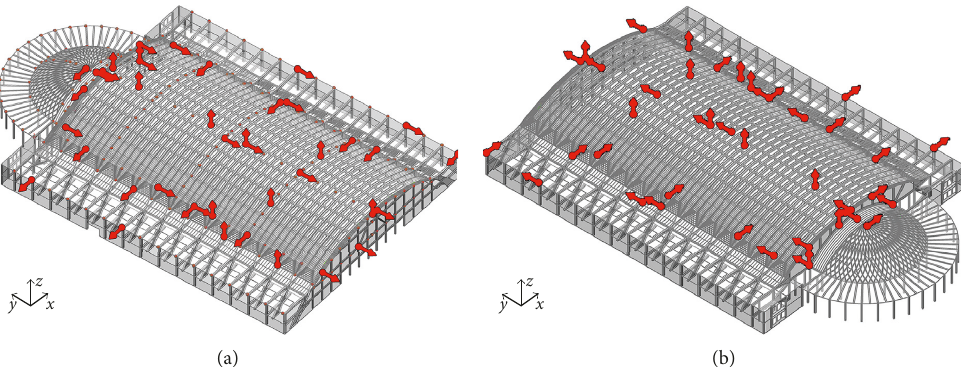
Figure 20: Sensor configuration layout: placement of sensors for the damaged structure, after the weighting of the different contributions.